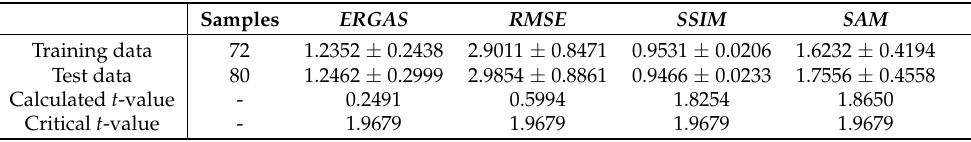
Figure 9. Qualitative comparison of CPNet with other eight pan-sharpening methods on the data from the QuickBird data set. Table 3. The quantitative comparisons of the proposed method on some training data and test data for the t